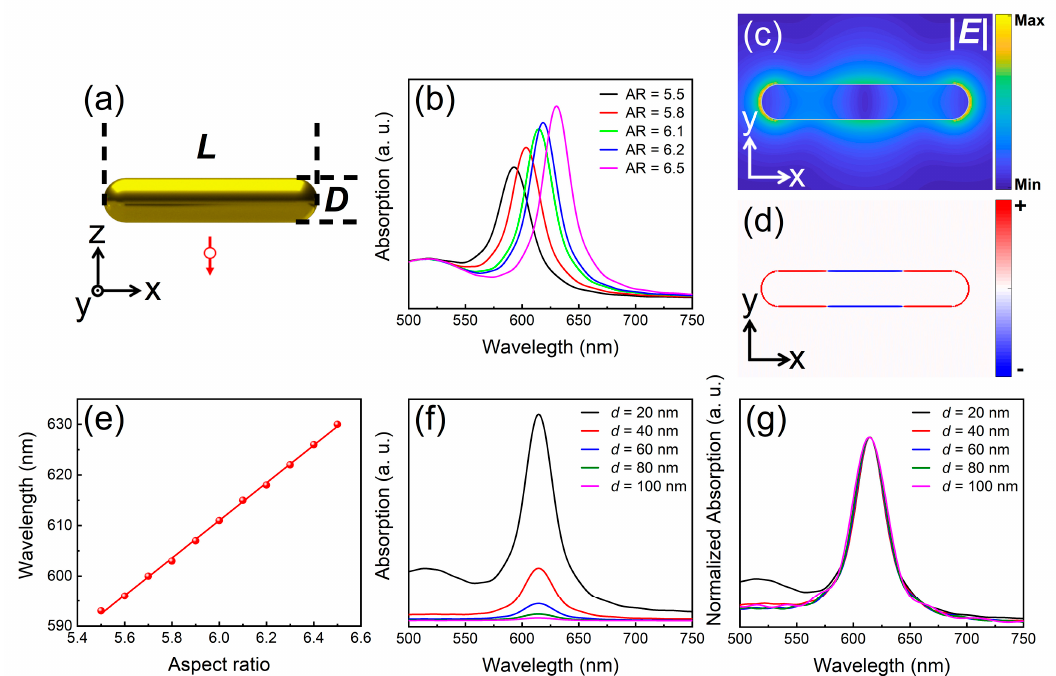
Figure 1. Excitation of the quadrupole mode in a GNR by using a dipole source. ( a ) Schematic showing a GNR with a length of L and a diameter D and a dipole source placed nearby. ( b ) Absorption spectra calculated for GNRs with different aspect ratios. Electric field ( c ) and surface charge ( d ) distributions calculated for a GNR with AR = 6.1 at λ = 615 nm. ( e ) Dependence of the resonance wavelength on the aspect ratio of the GNR. ( f ) Absorption spectra calculated for the long GNR (AR = 6.1), which is excited by a dipole source placed at different distances ( d ). ( g ) Normalized absorption spectra of the long GNR shown in ( f ).